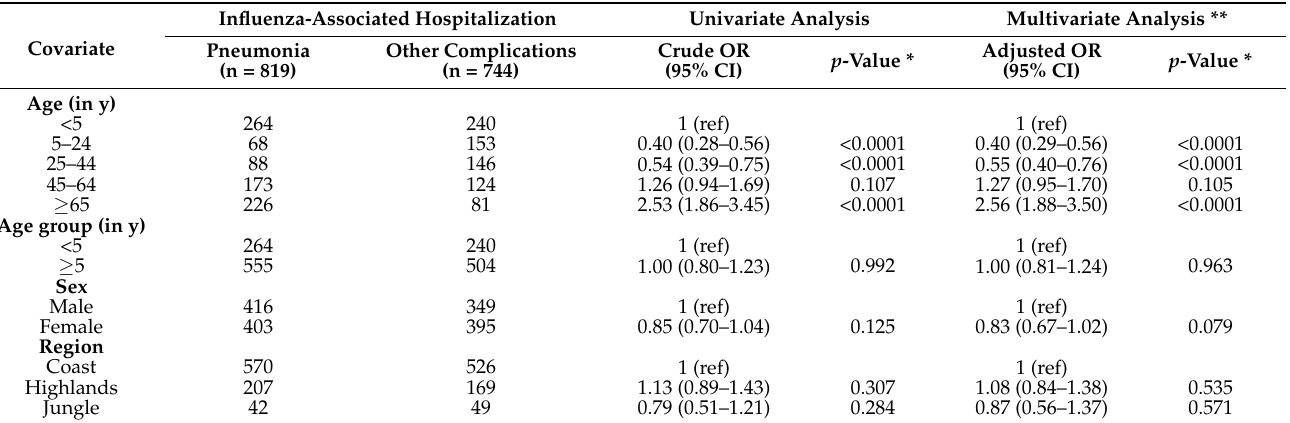
Table 5. Influenza respiratory tract infections by age, sex, and region in hospitalized patients in Peru,